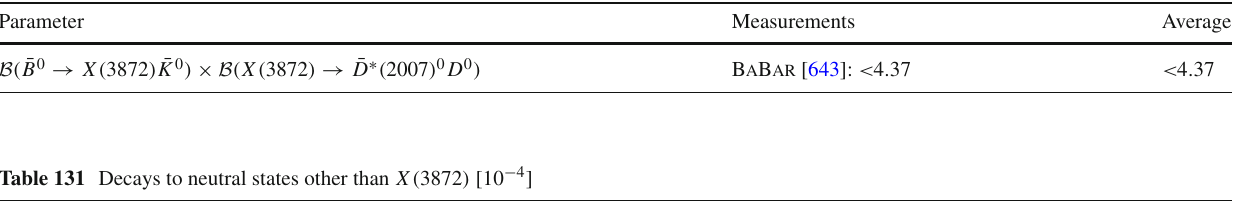
Table 130 Decays to X ( 3872 ) with X ( 3872 ) → D ¯ D [ 10 − 4 ]